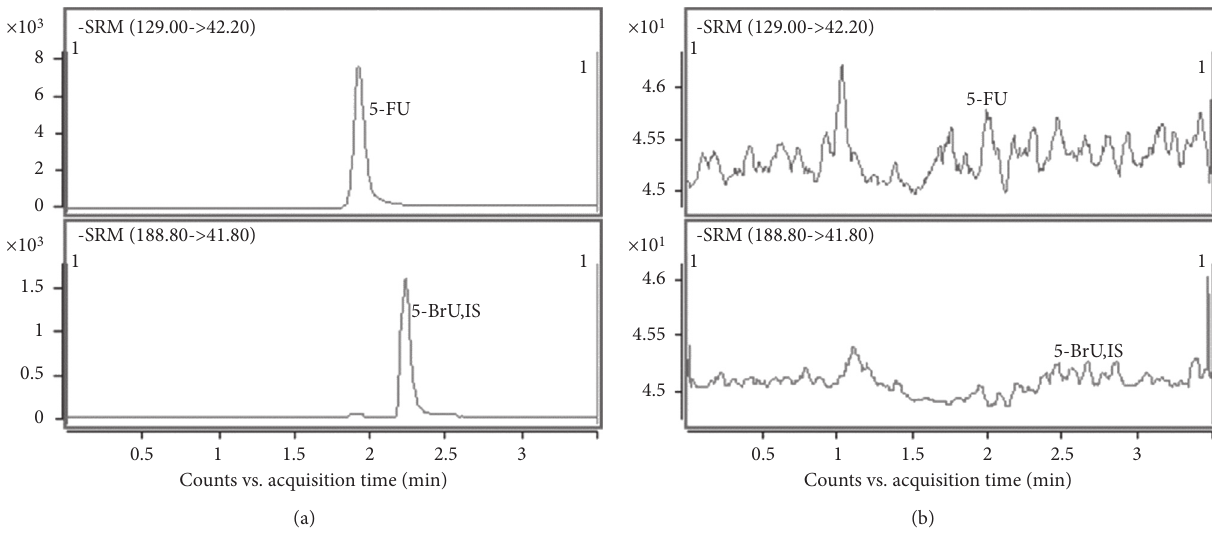
Figure 3: Comparative chromatograms of carry-over of 5-FU. (a) Highest calibration standard; (b) blank sample.